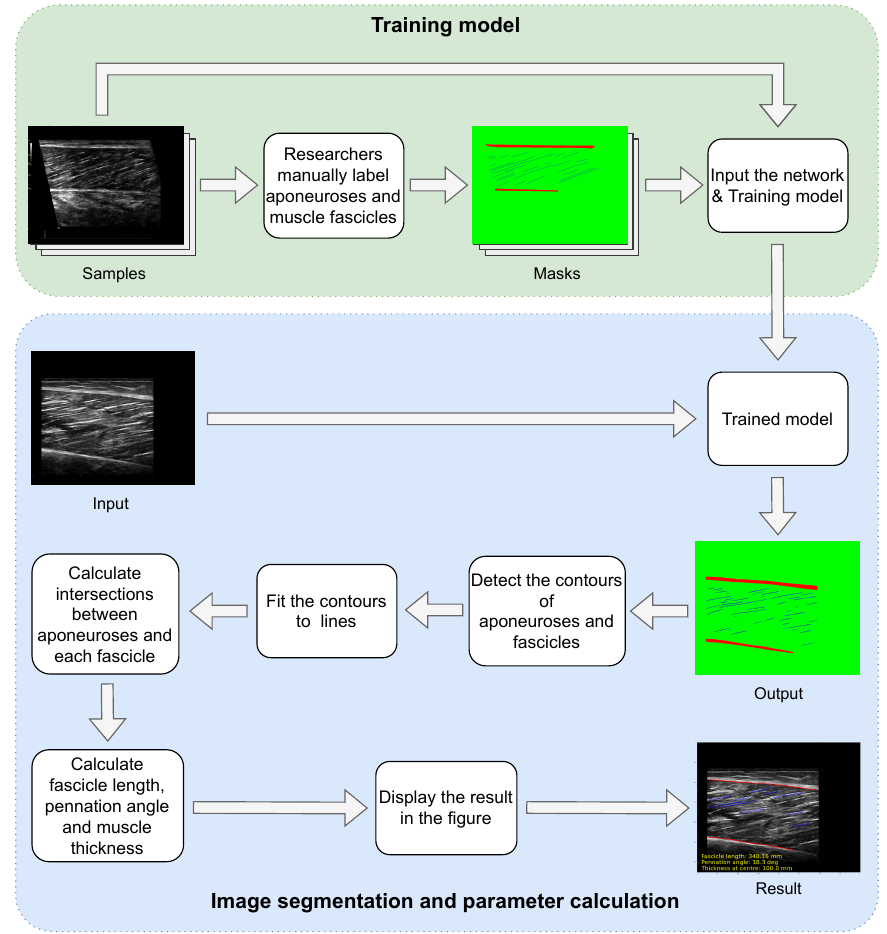
Figure 1. Processing flow of the proposed method. The process consists of two parts, namely model training and image analysis. In the training part, the manually labeled dataset is fed into RS-Unet for training. The trained model can segment the muscle ultrasound images directly. The outputs are calculated to obtain the final muscle